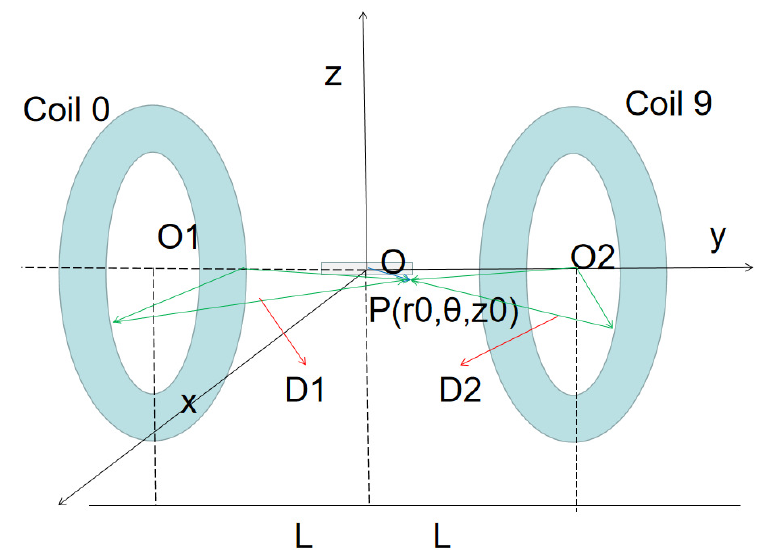
Figure 3. Simplified diagram of axial coil position